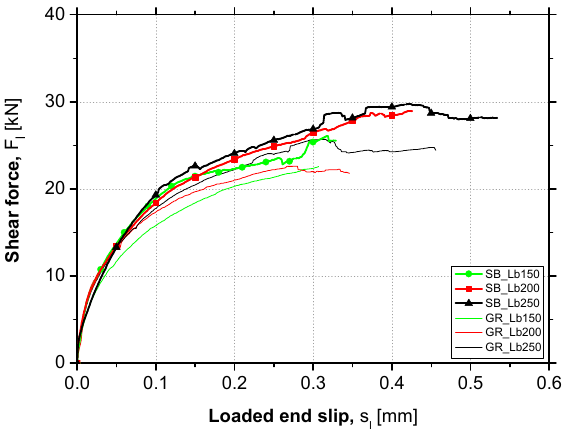
Figure 8. Average curves of the pull shear force vs. loaded end slip.